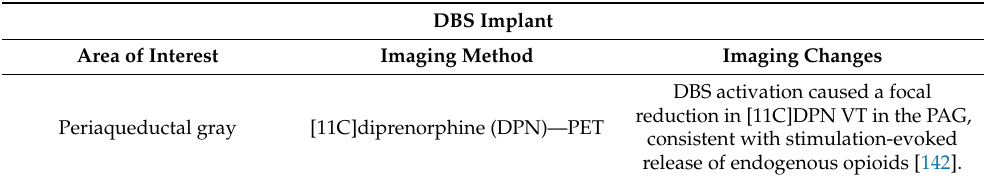
Table 2. Imaging changes/potential imaging biomarkers in response to various neurostimulation methods for chronic